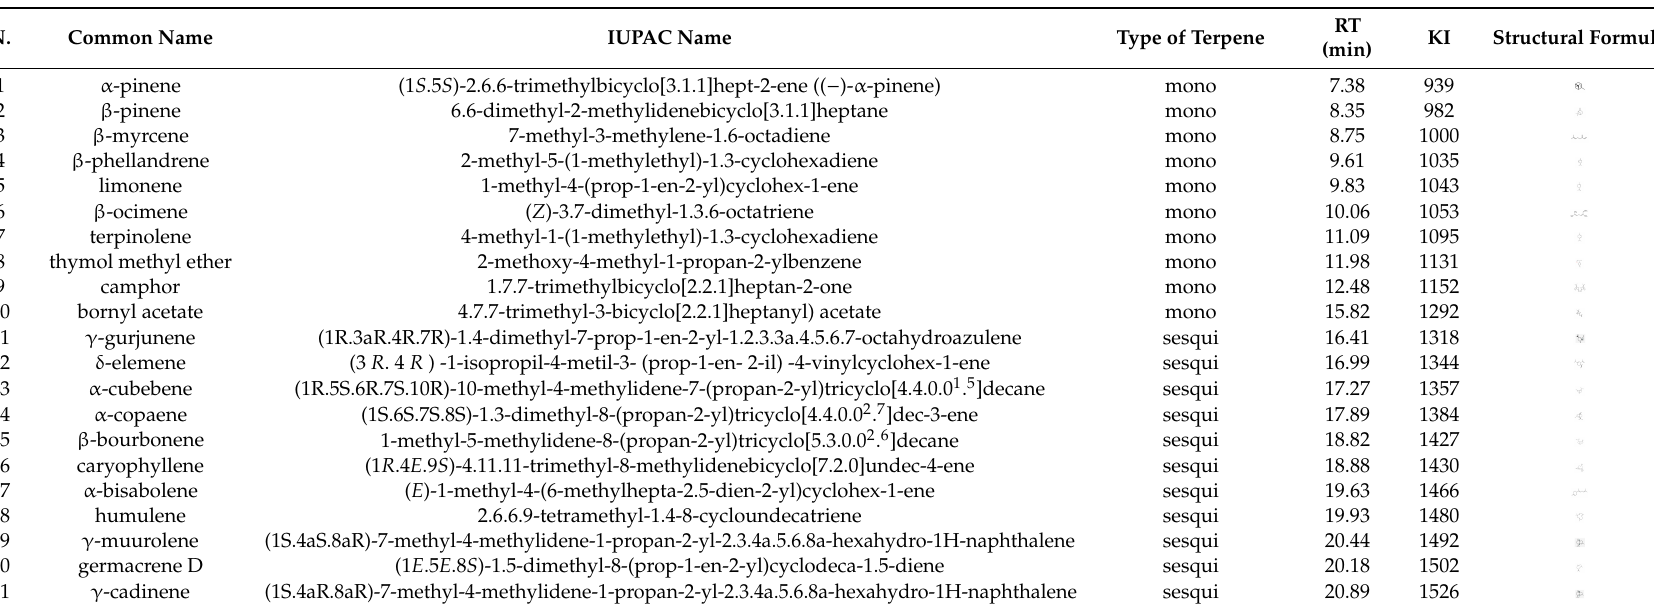
Table 1. Volatile organic compounds identified using gas chromatography / mass spectrometry (GC / MS) analysis in the head space of Calabrian pine needles. RT, retention time; KI, retention